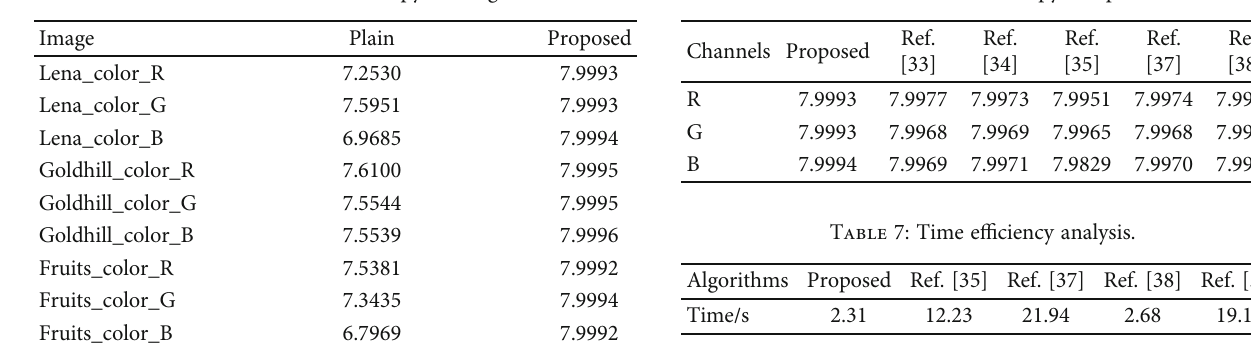
Table 5: Information entropy of images. Table 6: Information entropy comparison.